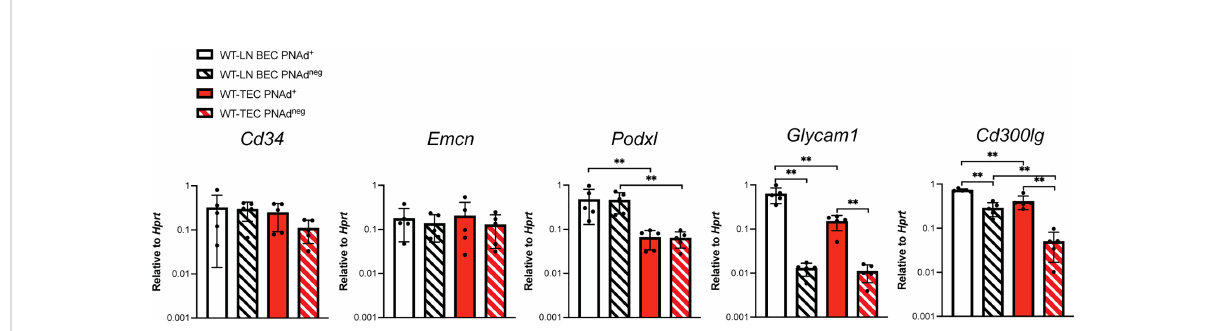
FIGURE 4 Scaffolding proteins are expressed at signi fi cantly lower levels in PNAd + TEC than in LN PNAd + BEC. C57BL/6 mice were I.P. injected with B16- OVA cells and tumors were harvested 14 days after implantation. LN were harvested from non-tumor-bearing mice. Endothelial cells were sorted from CD45+ depleted LN and I.P. tumor suspensions, and the expression levels of indicated RNA transcripts were determined by qPCR, as described in Methods. Data from one experiment presented as 2 - D CT relative to Hprt, n=5 LN or I.P. tumors per group. Results are mean ± SD